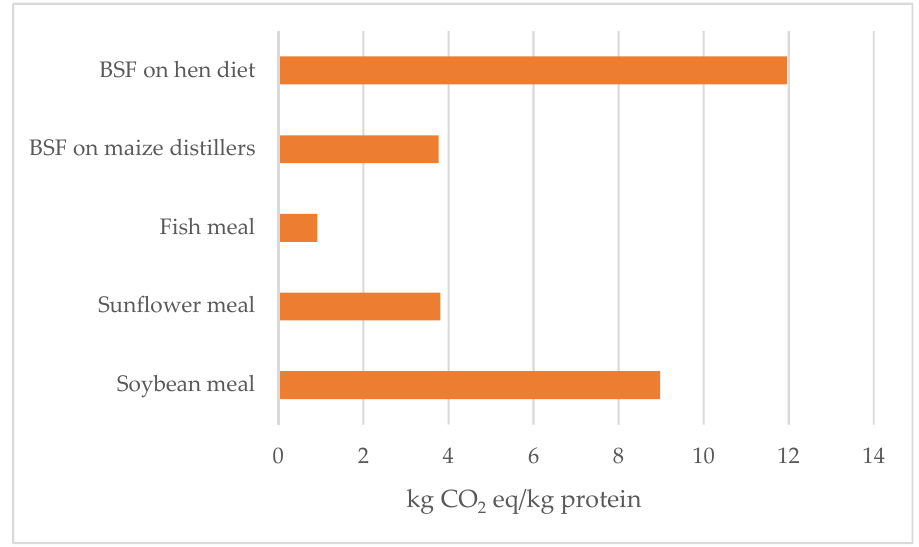
Figure 4. Climate change estimation to produce 1 kg of protein from black soldier fly (BSF) larvae production (on different substrates) from fish meal and from two vegetable feeds (sunflower meal and soybean meal).